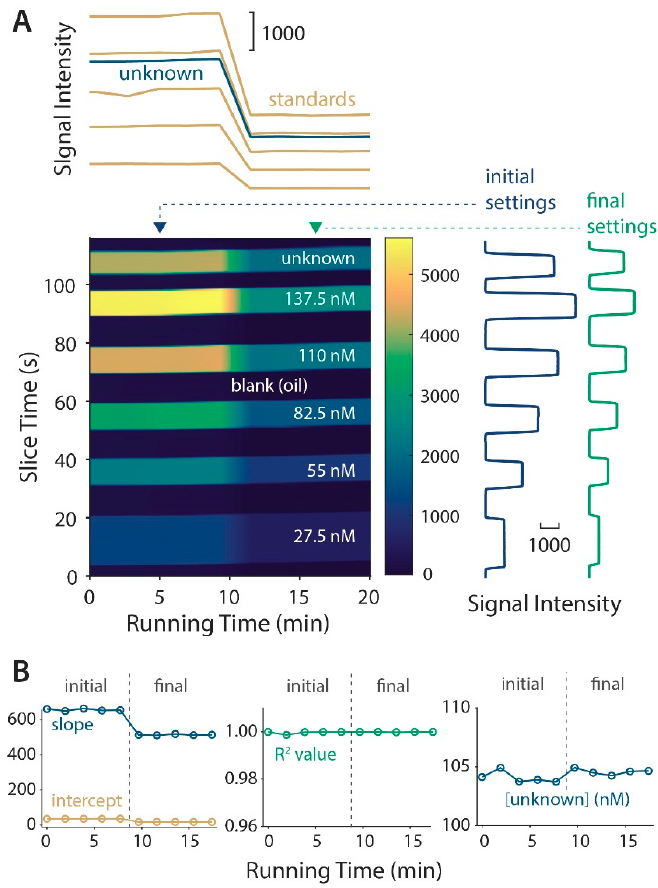
Figure 3. Data reshaping allowed for a unique visual inspection of the system, enabled by a precise droplet control with valves. ( A ) The raw data vector over time was reshaped into an image array using custom a MATLAB code, and image re-slicing permitted temporal tracking of each type of droplet (above) or original data recovery (right). ( B ) The system responded to the light intensity decrease by adjusting the calibration parameters, while the fit linearity and unknown determination were essentially unaffected.